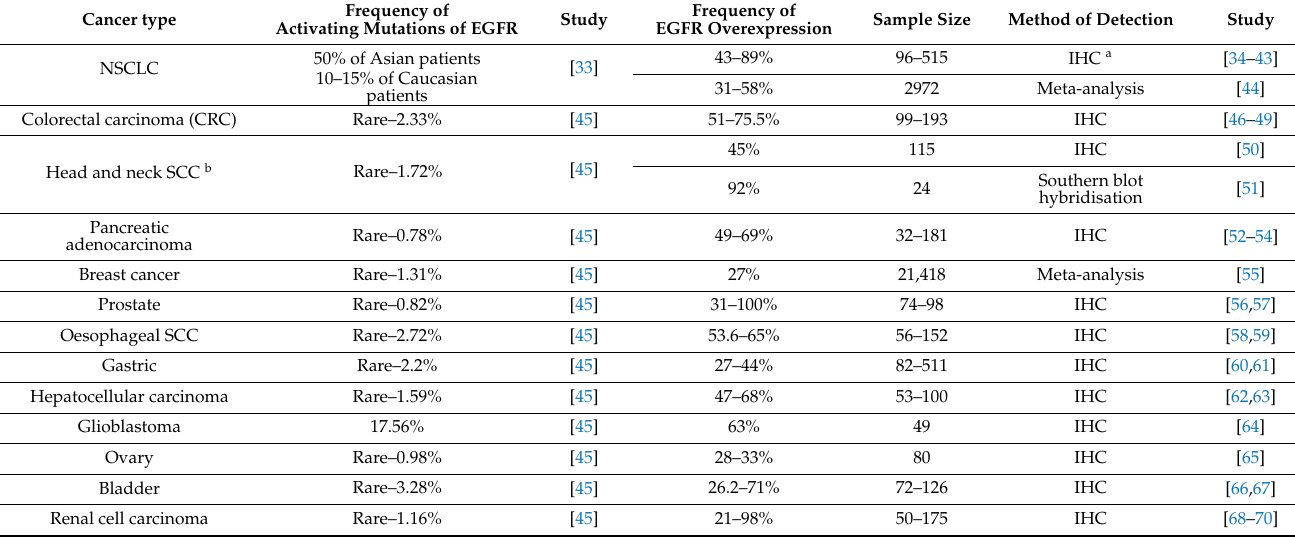
Table 1. Comparison of the incidence of EGFR-activating mutations and EGFR overexpression amongst common cancers. Cancer